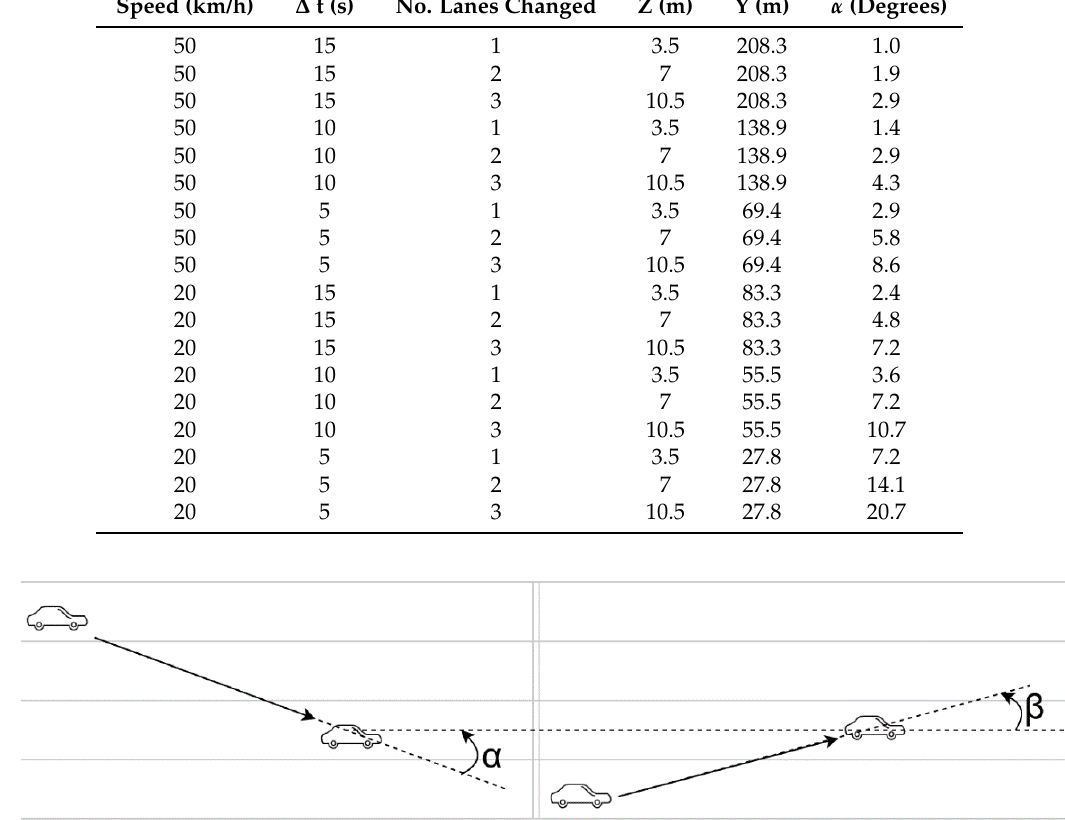
Figure 5. Example of two cars changing to the same